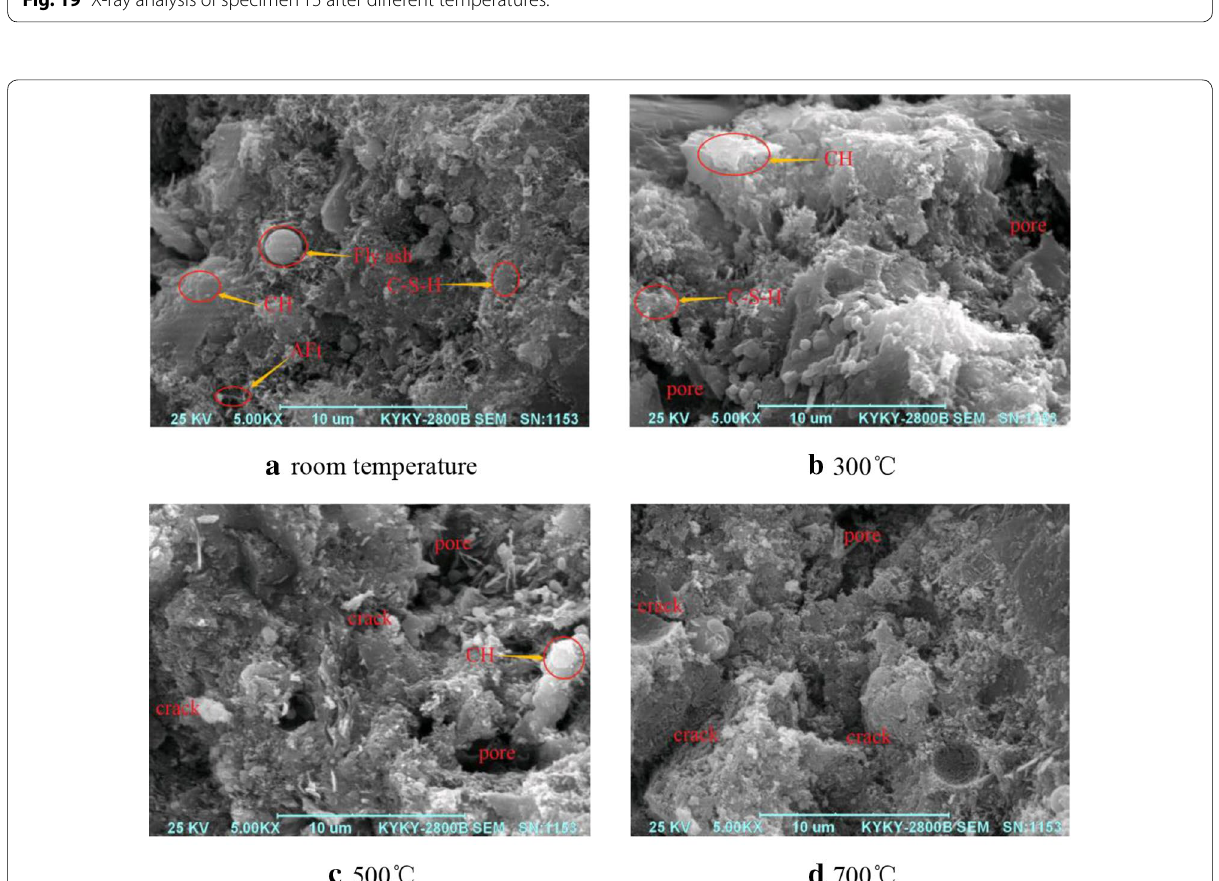
Fig. 20 SEM of specimen T5 after different